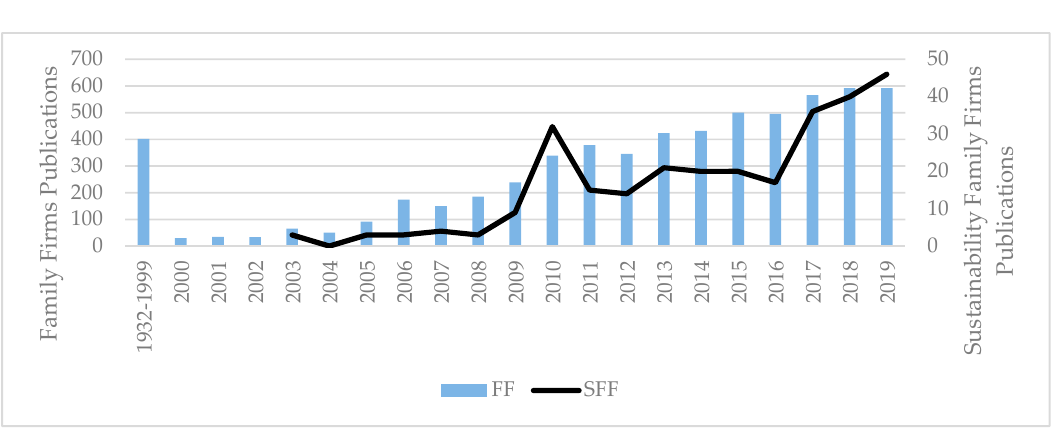
Figure 3. Evolution of Family Firms and Sustainability of Family Firms Literature. Note: FF (Family